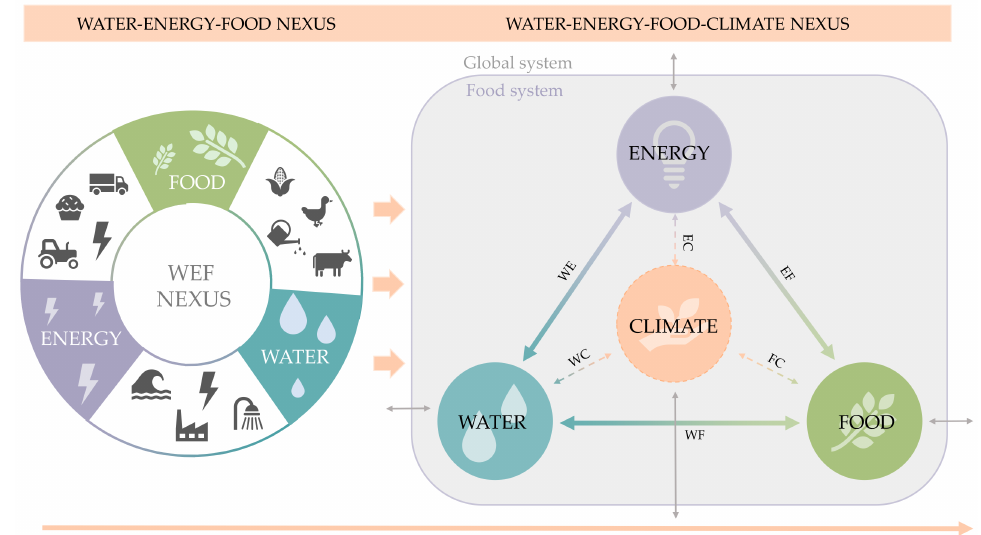
Figure 9. Current nexus approach vs. water–energy–food–climate nexus. Double-arrow lines represent the connection between the pillars and the global